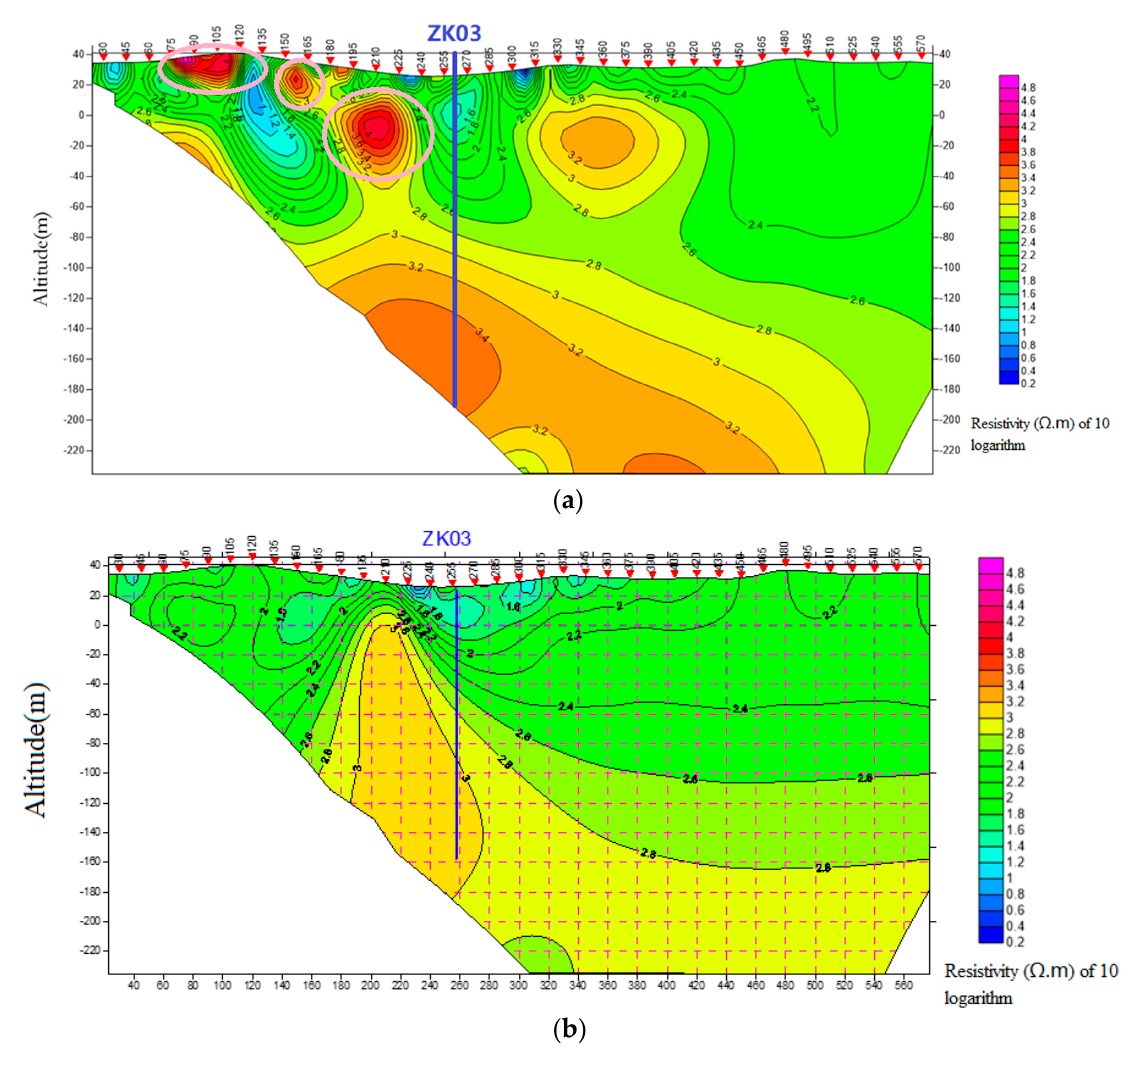
Figure 9. The resistivity sounding and pseudo − 3D resistivity inversion results of L1 survey profile. ( a ) Resistivity sounding result. ( b ) Pseudo − 3D resistivity result (the value of the median line in the figure is the base 10 logarithm of the resistivity. The blue lines indicate the locations of boreholes).